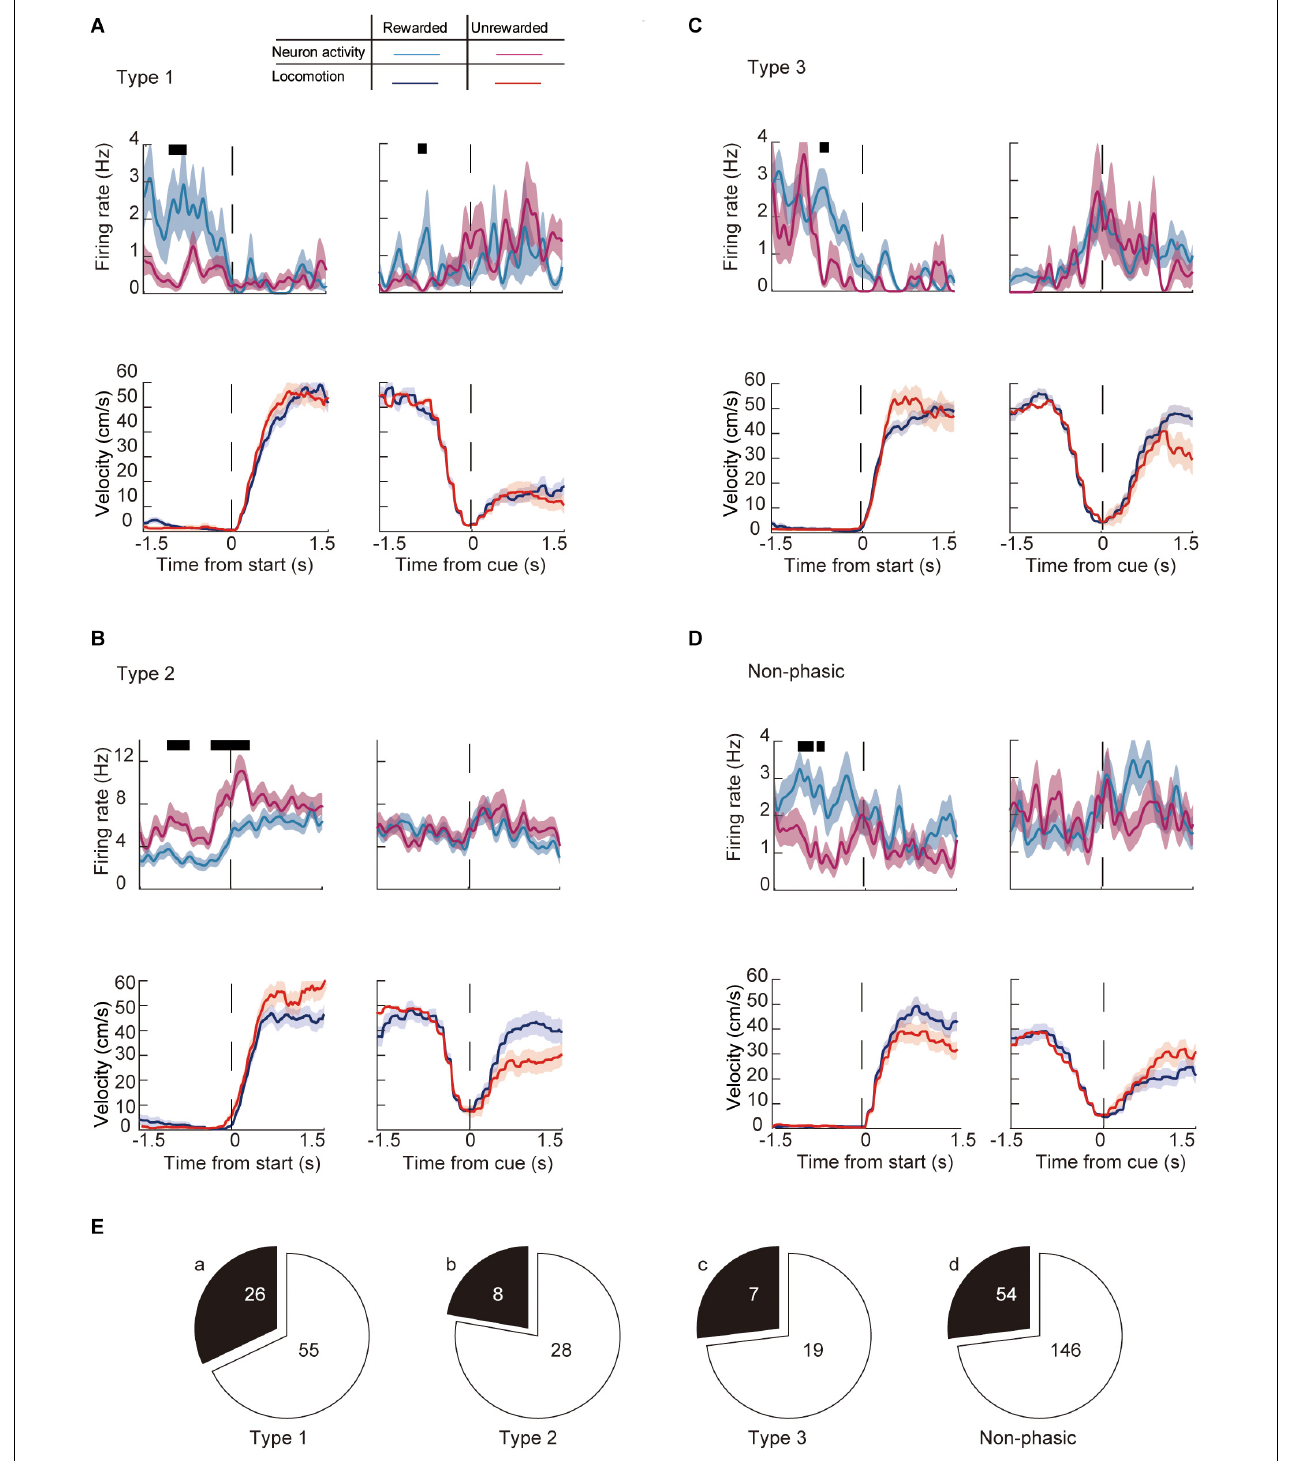
FIGURE 7 | Modulation of the firing activity of ACC neurons around the key task by behavioral outcomes in the previous trial. Examples of the running velocity (upper panels) and neuronal activity (lower panels) of (A) Type 1, (B) Type 2, (C) Type 3, and (D) non-phasic neurons ± 1.5 s from the start of the preparatory run, and cue presentation during previously rewarded (blue lines for the running velocity, cyan for the firing rate) and previously non-rewarded trials (red lines for the running velocity, magenta for the firing rate). Thick black lines in each panel represent significantly different time segments ( P < 0.05; see section “Materials and Methods”). (E) Number of significantly modulated (a) Type 1, (b) Type 2, (c) Type 3, and (d) non-phasic neurons. Shaded areas in each trace indicate